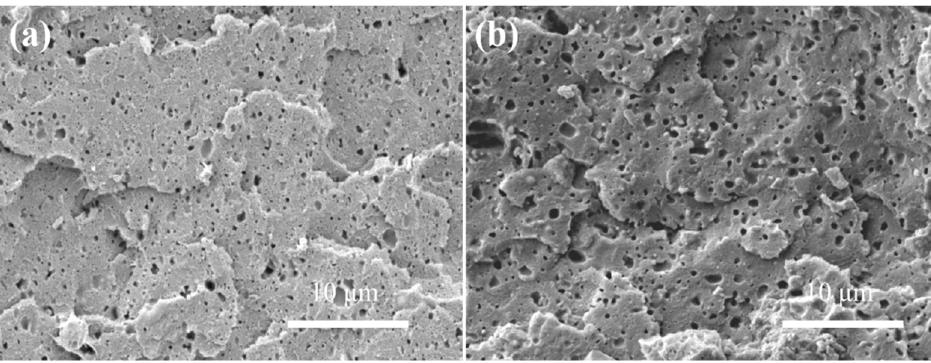
Figure 3. The fractured surface morphology of SAN/CPE blends with 10 wt.% ( a ) and 20 wt.% ( b ) CPE content. All blend samples for observation were quickly smashed after soaking in liquid nitrogen for 60 min.